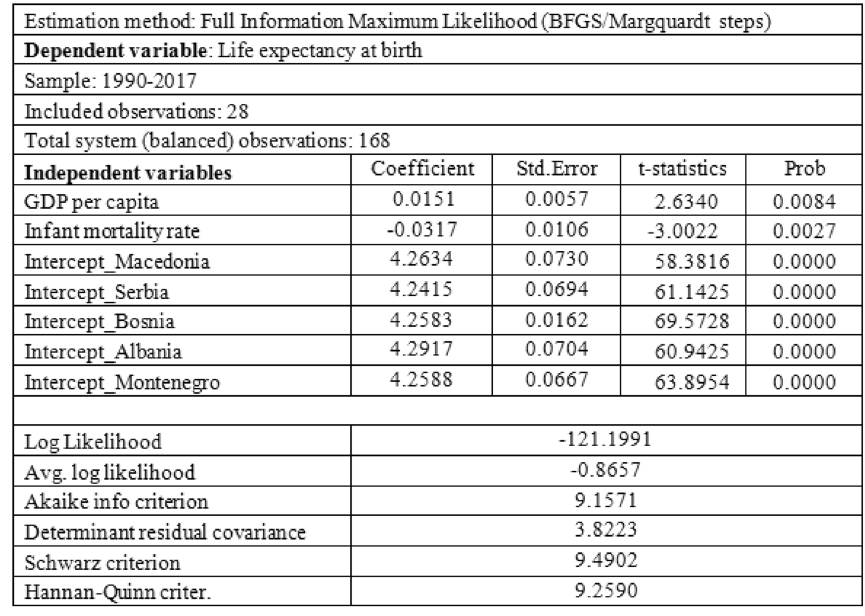
* Residual covariance matrix restricted to be diagonal in FIML estimation **Convergence achieve after 175 iterations